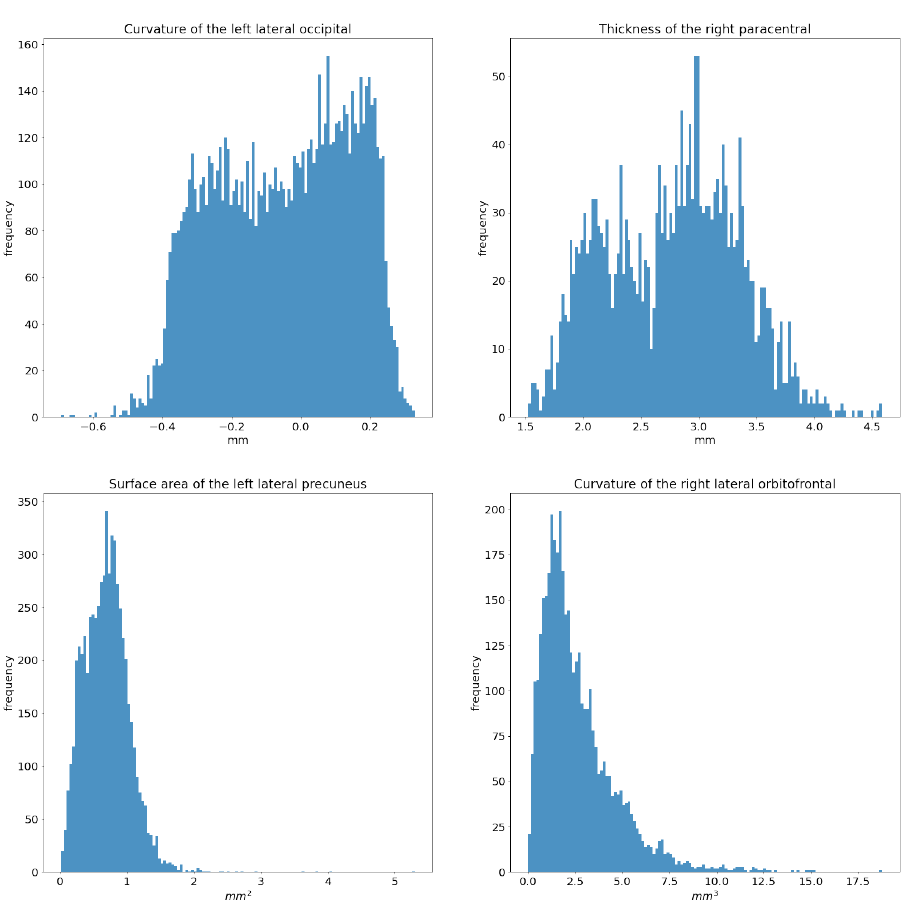
Figure 3. Distribution of the S a values within different brain